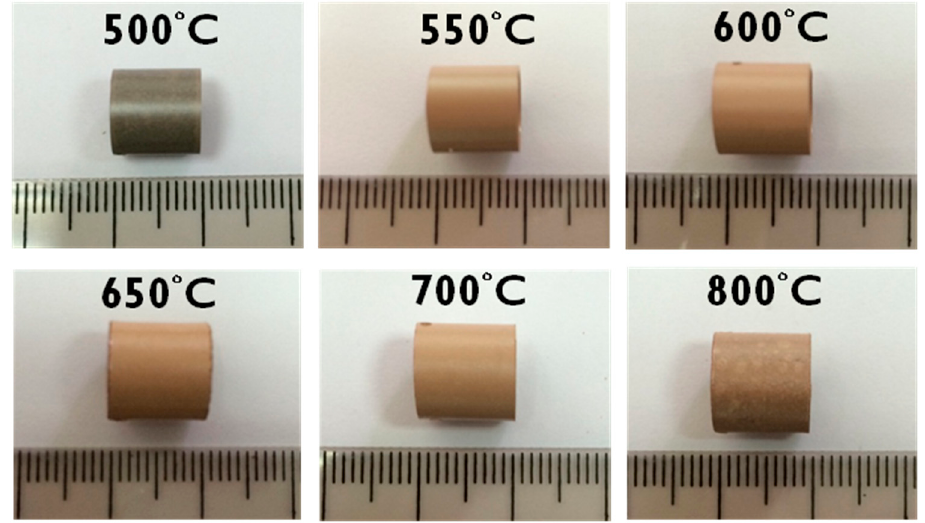
Figure 2. Surface features of the as-received Zircaloy-4 cladding specimens after the oxidation tests. (Time for testing: 500 °C for 150 h, 550 °C for 96 h, 600 °C for 50 h, 650 °C for 50 h, 700 °C for 10 h, and 800 °C for 3 h.).